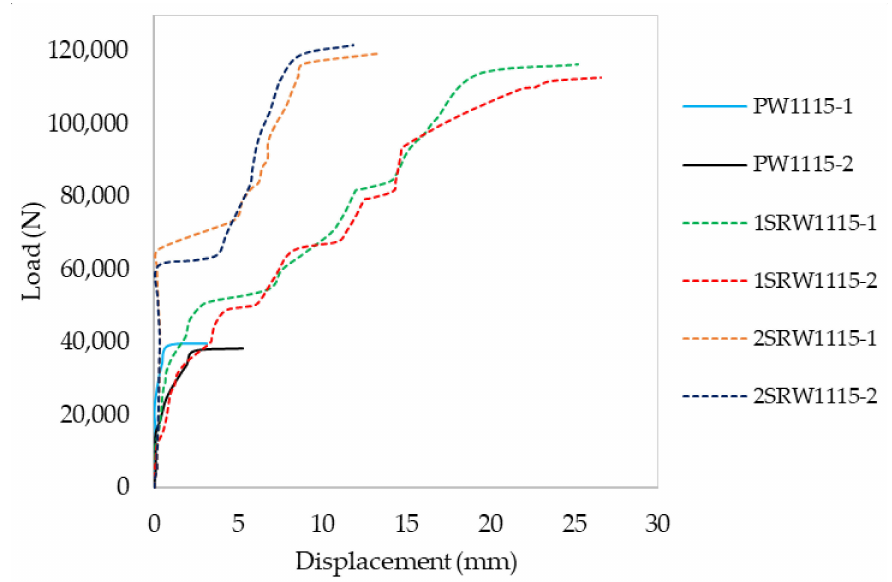
Figure 10. Load vs. displacement curve for large-scale masonry wall